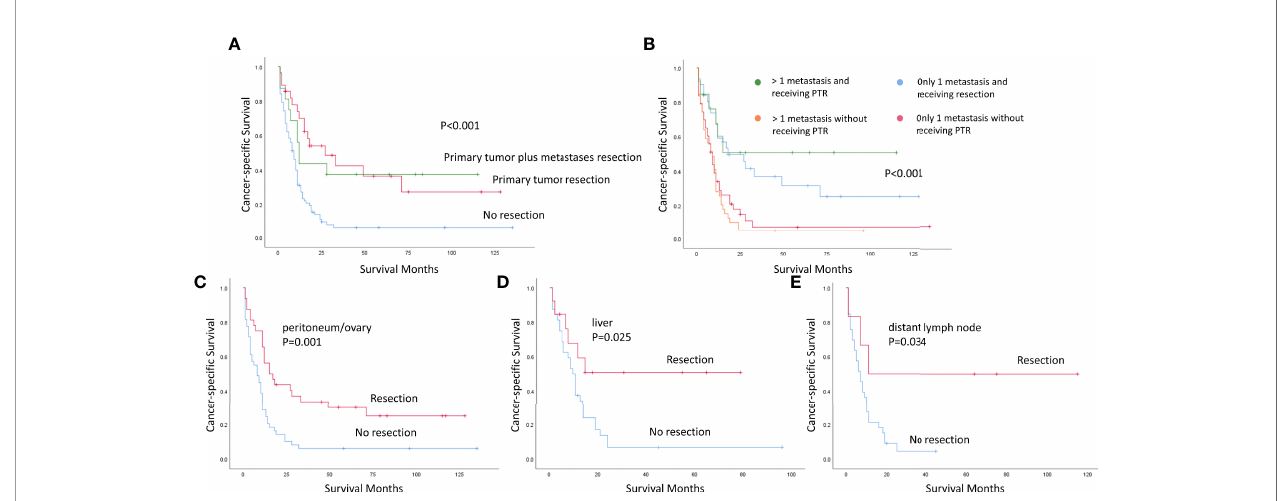
FIGURE 3 | Kaplan – Meier survival curves for patients with stage IV gastric neuroendocrine carcinoma in the unweighted study population [ A : with or without distant metastases resection; B : with 1 or more than 1 distant metastasis. Subgroup analysis by different distant metastatic site ( C : peritoneum/ovary, D : liver, E : distant lymph node)]. PTR, primary tumor